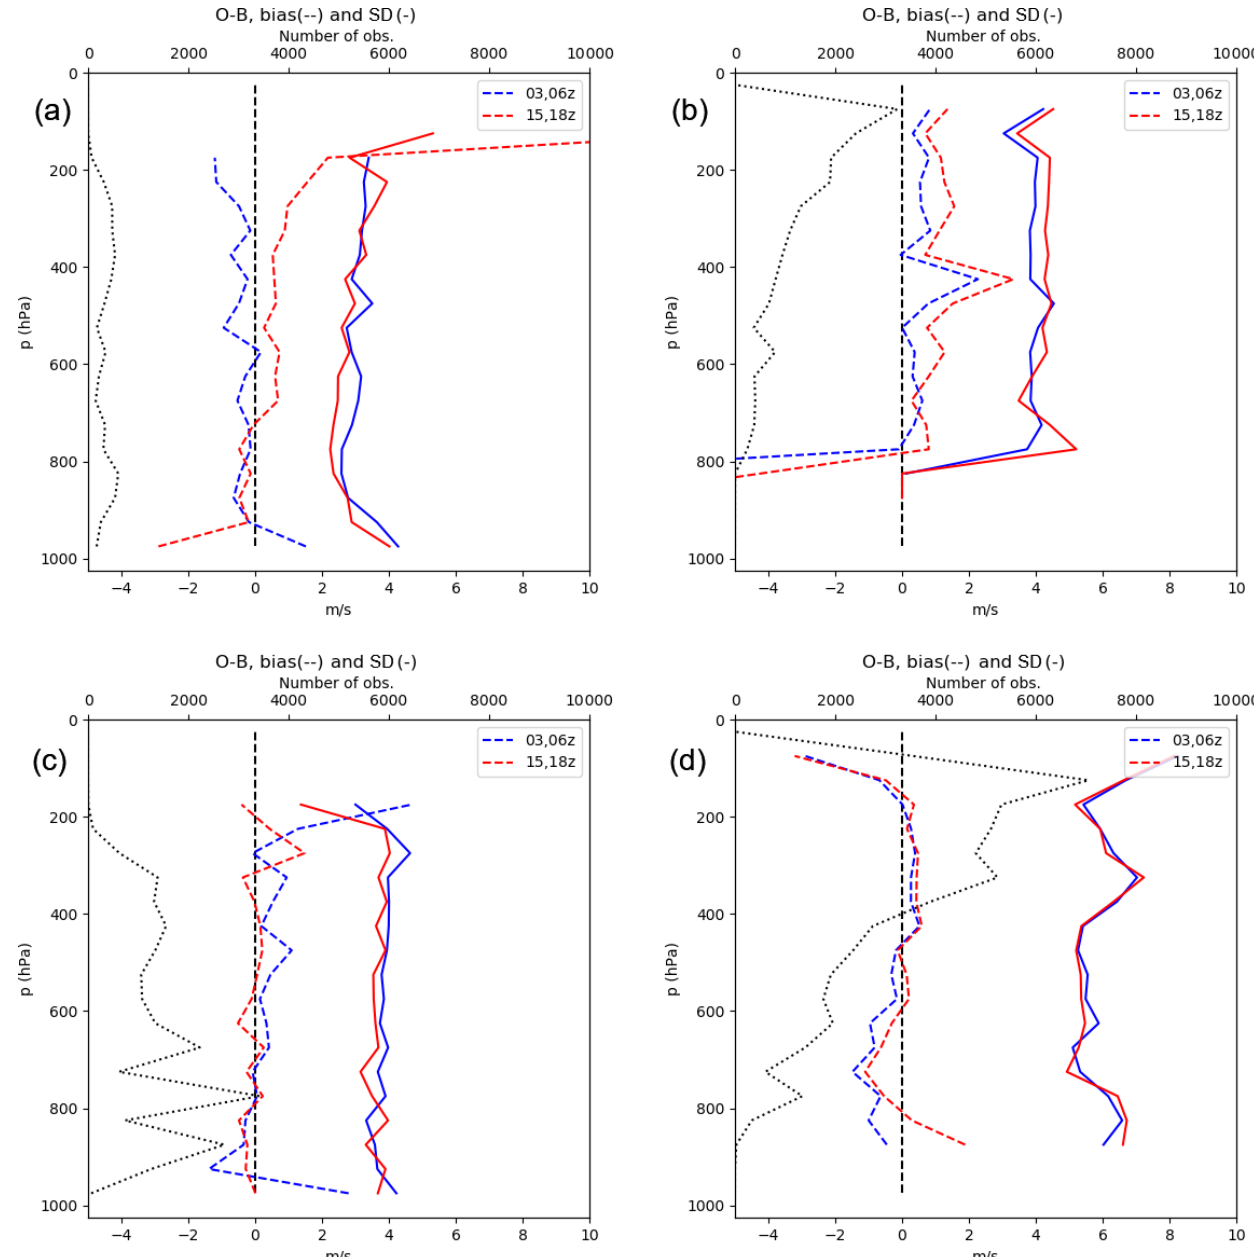
Figure 3. The bias and standard deviation of the observation minus background (O − B) for the laser A (a, b) and laser B (c, d) periods of Aeolus HLOS data. The Mie data are in the left-hand column, and the Rayleigh data are in the right-hand column. Blue lines mark ascending orbits and red lines descending ones. The black dotted line shows the respective number of Aeolus